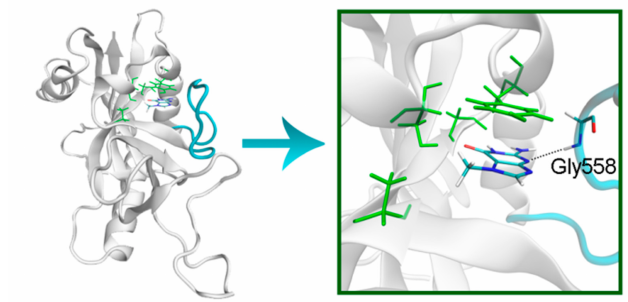
Figure 9. D-loop conformation in PARP-15 and its interaction with 7-MG. The NA binding site is colored in green, and D-loop in blue.